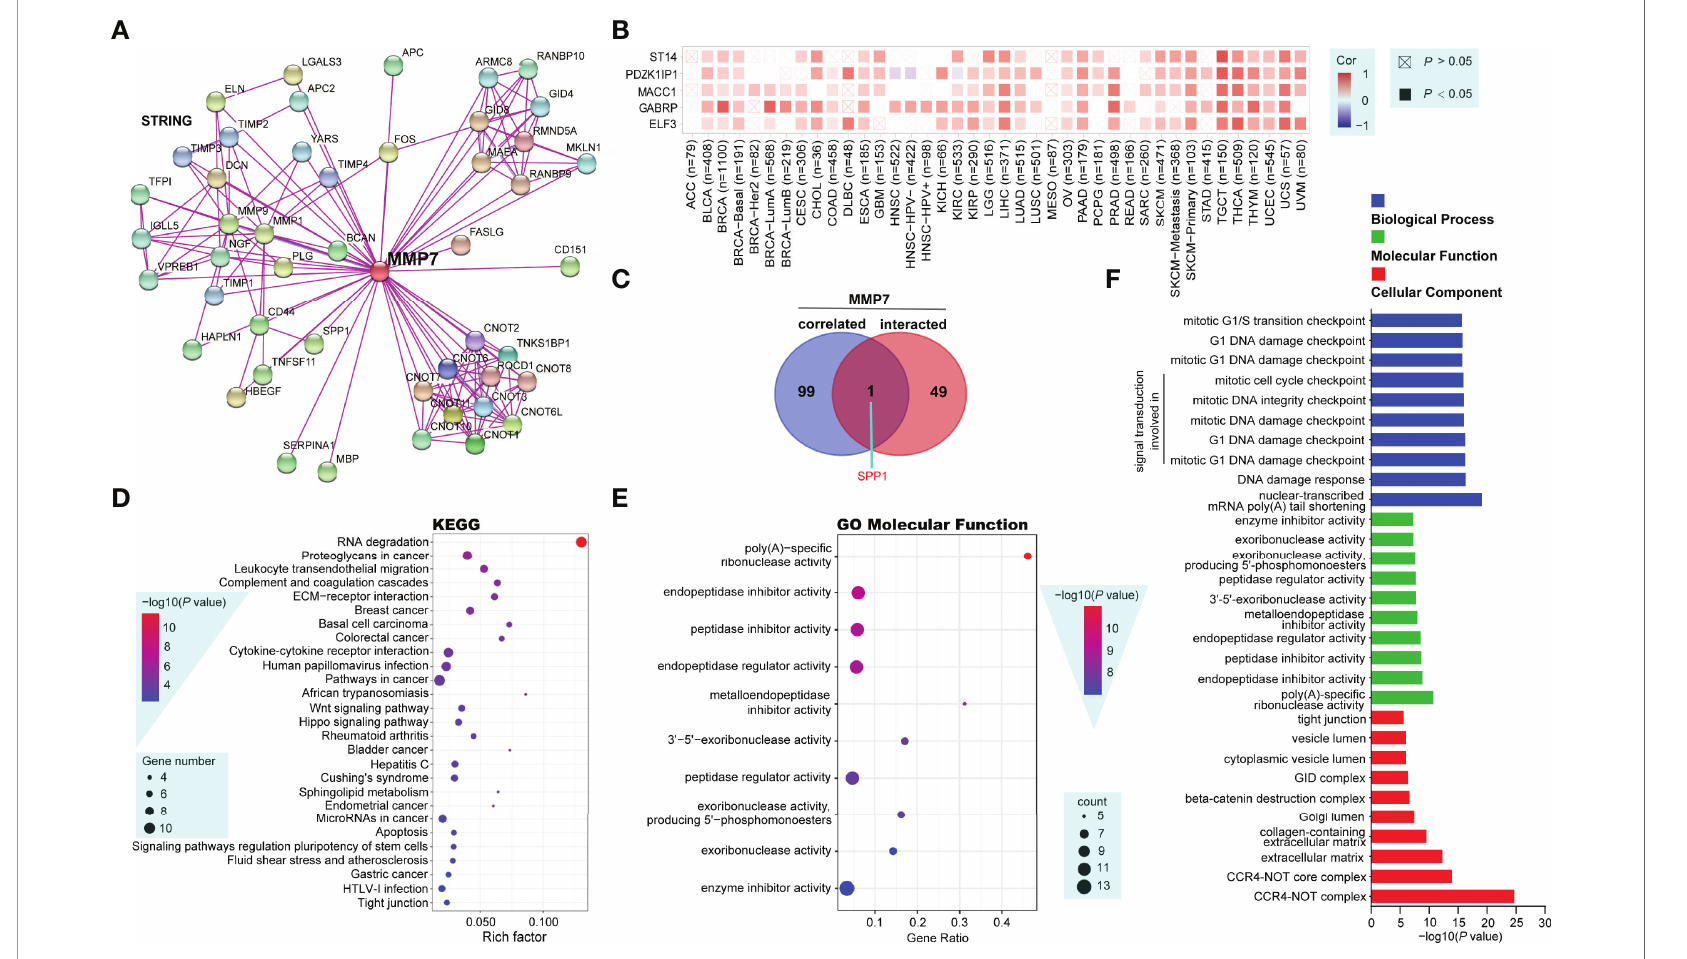
FIGURE 8 | Functional enrichment analysis of MMP7-related genes (String, Metascape and other open-access web servers). (A) Protein – protein interaction network of 50 experimentally determined MMP7 interacting genes by the web server of String. (B) The heatmap showing the correlation analysis between the expression of MMP7 and ELF3, GABRP, MACC1, PDZK1IP1, and ST14 in different cancer types. (C) The Venn diagram presenting the intersection analysis of MMP7-interacting and MMP7 -correlated genes. (D) The dot bubble of the Kyoto Encyclopedia of Genes and Genomes (KEGG)-enriched terms based on MMP7-interacting and MMP7 -related genes, in which the most signi fi cant was marked in red. (E) The dot bubble of gene ontology (GO) enrichment analysis in molecular function terms with the most signi fi cance marked in red. (F) Bar plot of typical enriched GO terms including biological process (blue), molecular function (green), and cellular component (red), the top 10 GO terms in each category are illustrated according to the P